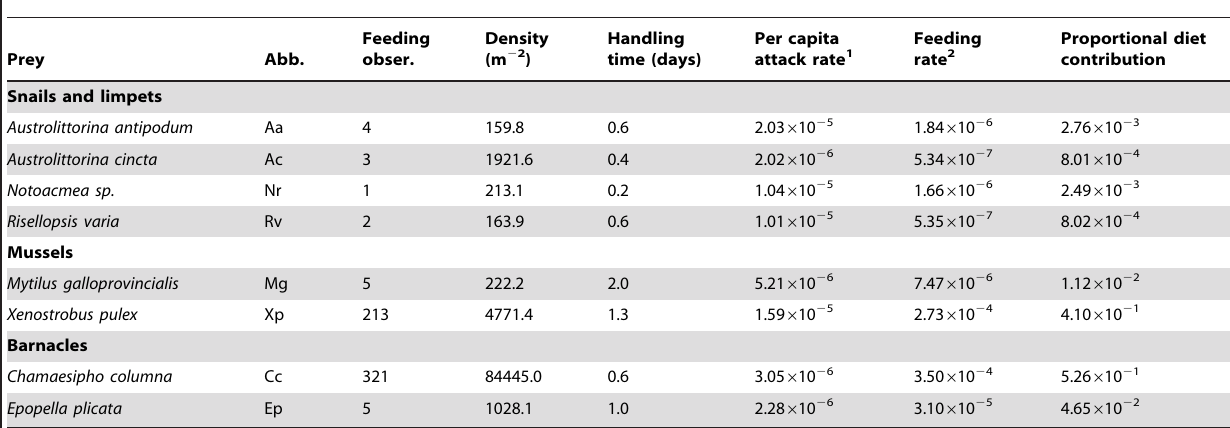
Table 1. Haustrum scobina prey-specific foraging